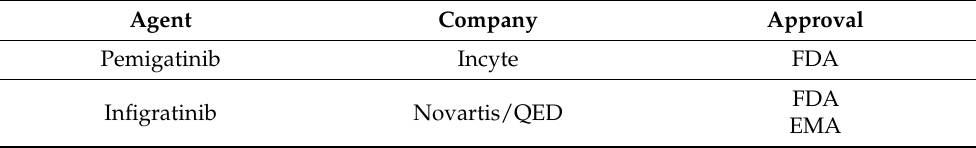
Table 2. Approved agents in FGFR2-positive